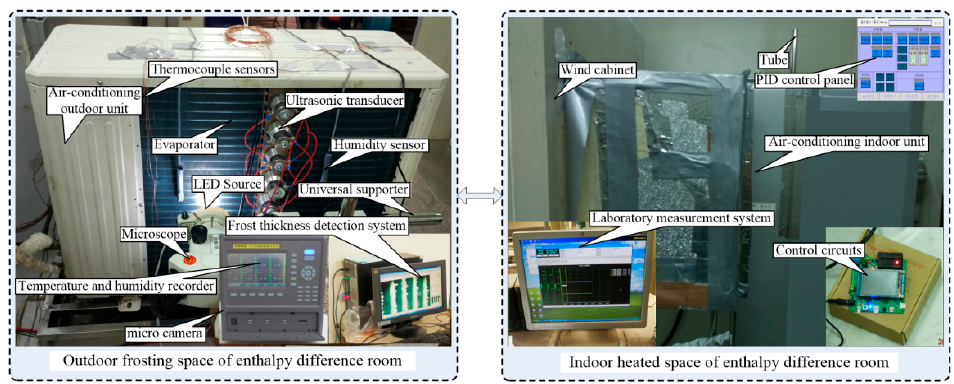
Figure 14. Photographs of the defrosting experiment involving the ASHP unit installed in an enthalpy laboratory.